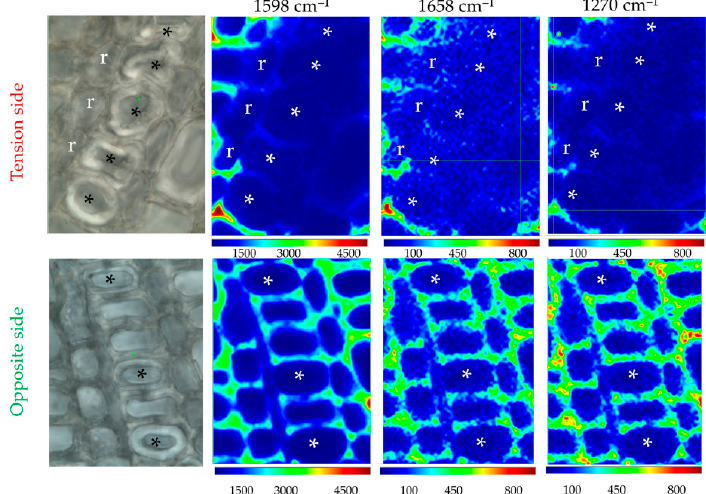
Figure 6. Raman chemical imaging of major aromatic/lignin peaks. This illustrates the effects of the G ‐ layer on its closest neighbor xylem cells. The identical color scale helps the comparison of ten ‐ sion/opposite G ‐ layers for a given peak. Lignin depletion is noticed in the vicinity of certain vessels (*), whatever the cell type considered (ray cells/r, fiber ‐ tracheid or large vessel). It is particularly observed in tension side wood contrary to the opposite side. Cambial zone is at the bottom of each image. Bar = 10 μ m. Normalization was done on the cellulose peak 380 cm –1 .